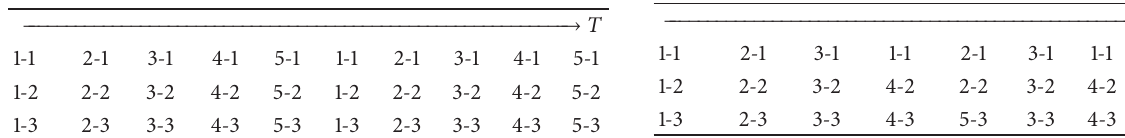
Table 2: Original frame loop sequence. Table 3: Frame division and